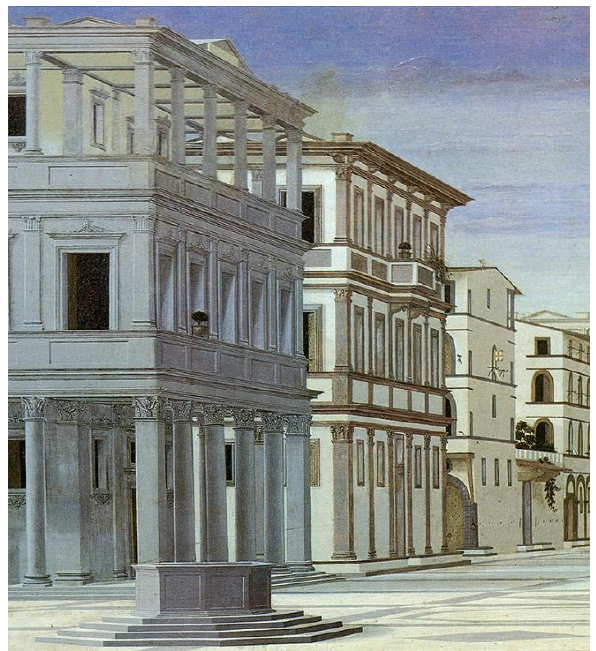
Figure 1. Città ideale (detail), Galleria Nazionale delle Marche, Urbino 1470-1490